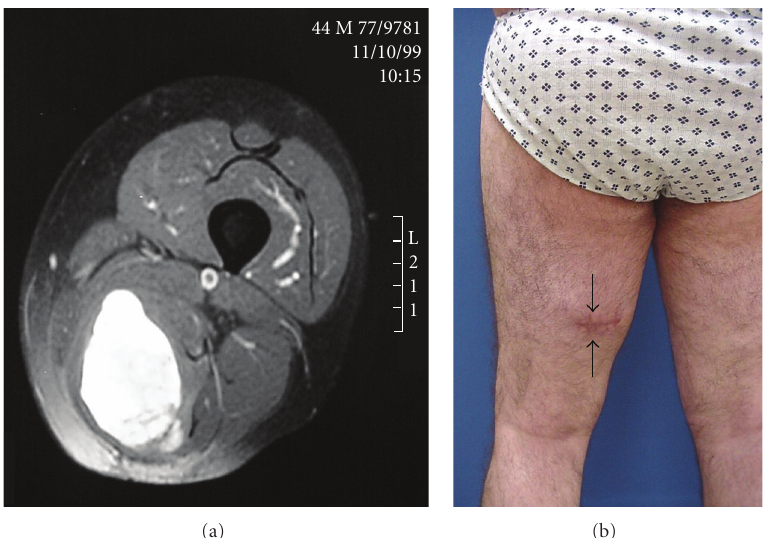
Figure 1: (a) Axial thigh T2-MR showing a hyperintense mass in the posterior aspect of the thigh. (b) Clinical image showing the wrong incision (black arrows) performed to excise the lump with the preoperative diagnosis of a benign lump. Histologic analysis established that the mass was a sarcoma; the excision had thus been a whoops procedure.